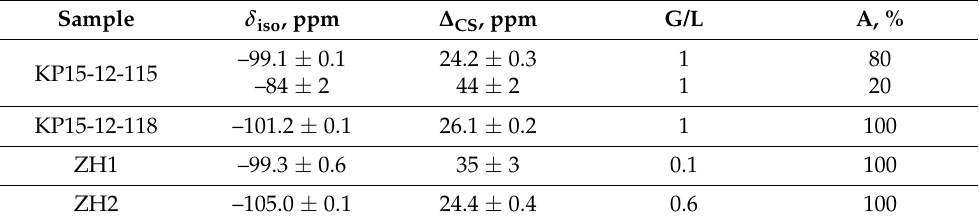
Table 4. The fitted parameters of the 29 Si MAS NMR of the impact